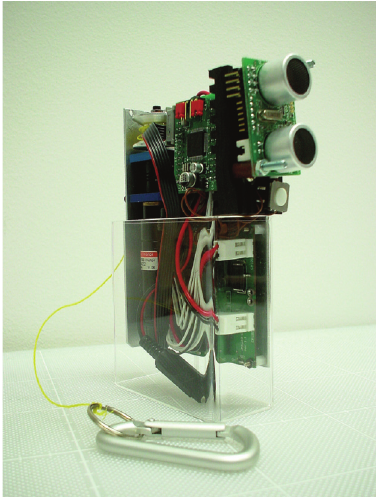
Figure 4: First developed prototype of CyARM.